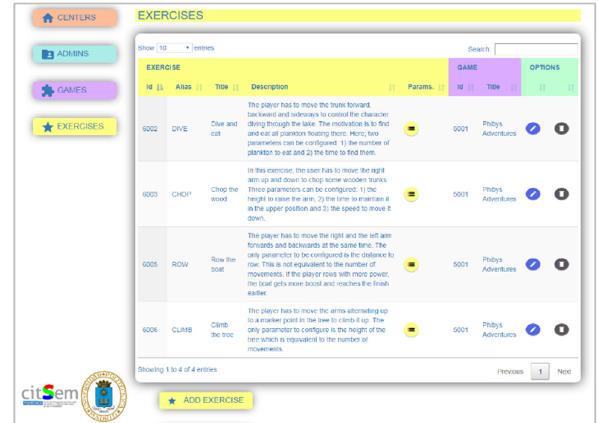
Fig. 12. View of the form to add new games to the platform. The first one is already